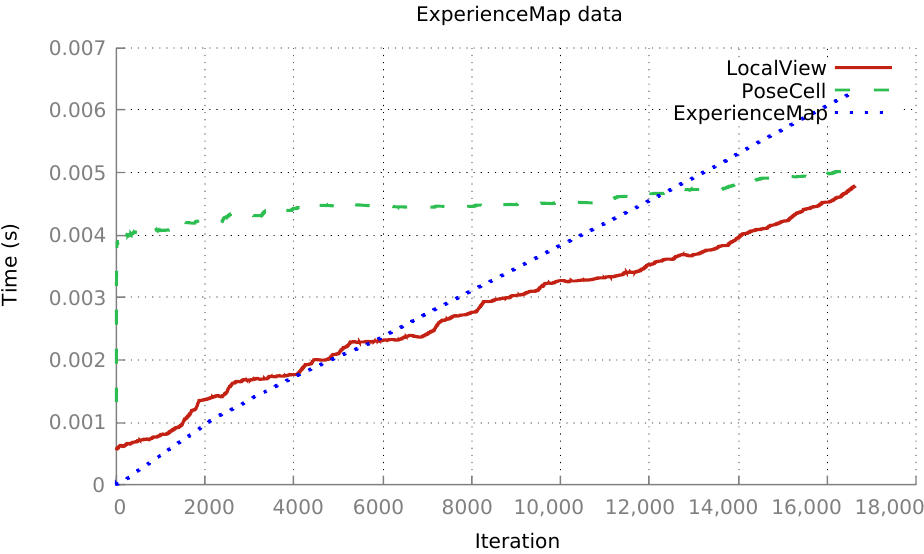
Figure 8. Average execution times of xRatSLAM using the RecodedLV module implementation. LocalView average: 4.79 ms. PoseCell average: 5.01 ms. ExperienceMap average: 6.30 ms. Total time: 121.0